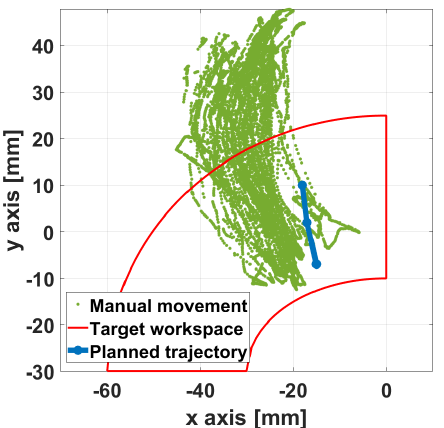
Figure 26. The measurement data of the AA movement in the case of the attached prototype moving by